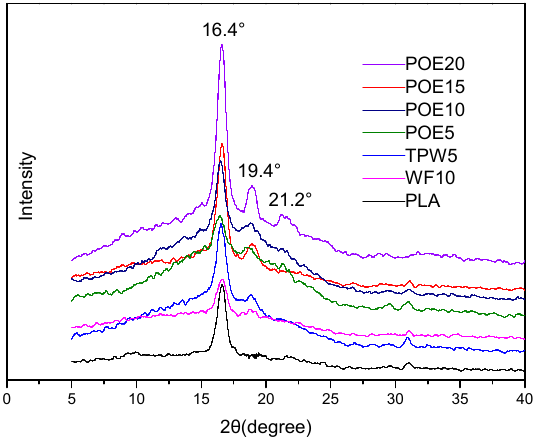
Figure 3. X-ray diffraction (XRD) spectra of 3D printing materials.